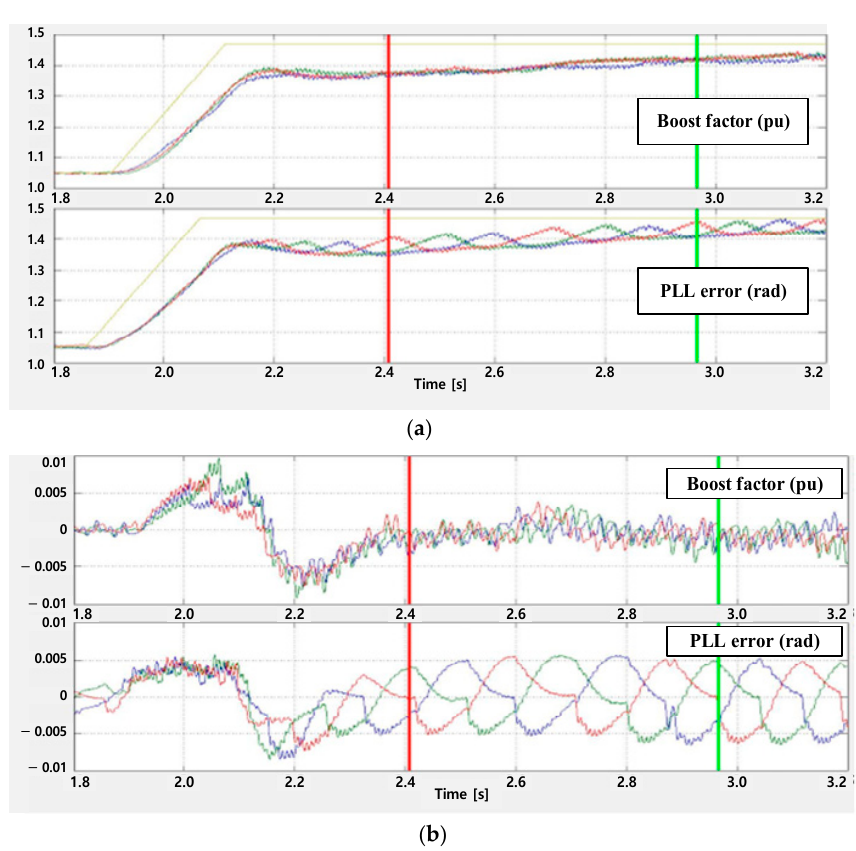
Figure 8. Results of Boost factor in the step response test. ( a ) Boost factor. ( b ) Internal PLL error.